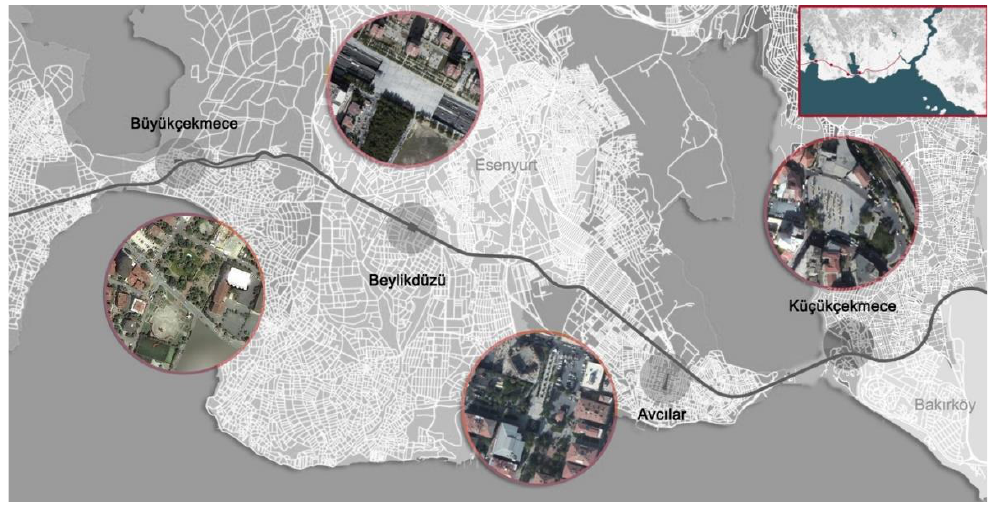
Figure 1 Location of four squares.